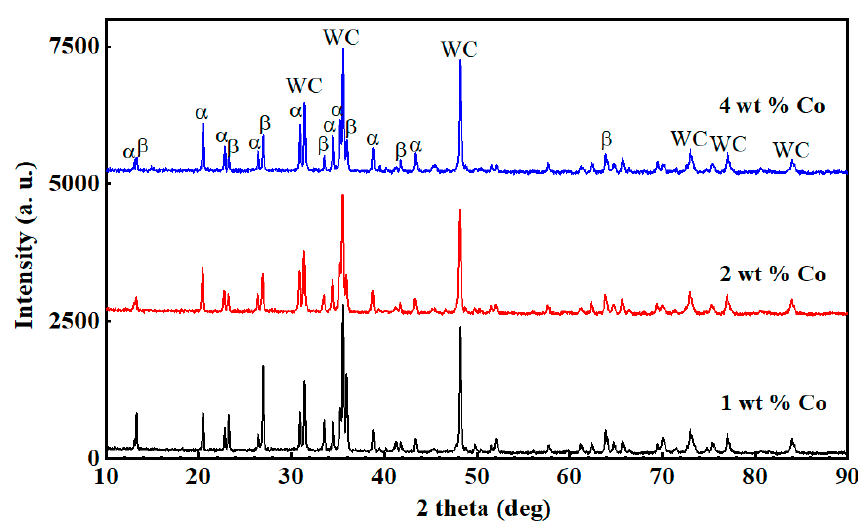
Figure 7. Effect of the Co content on the phase composition of Si 3 N 4 -based ceramic material at 10 wt % WC.